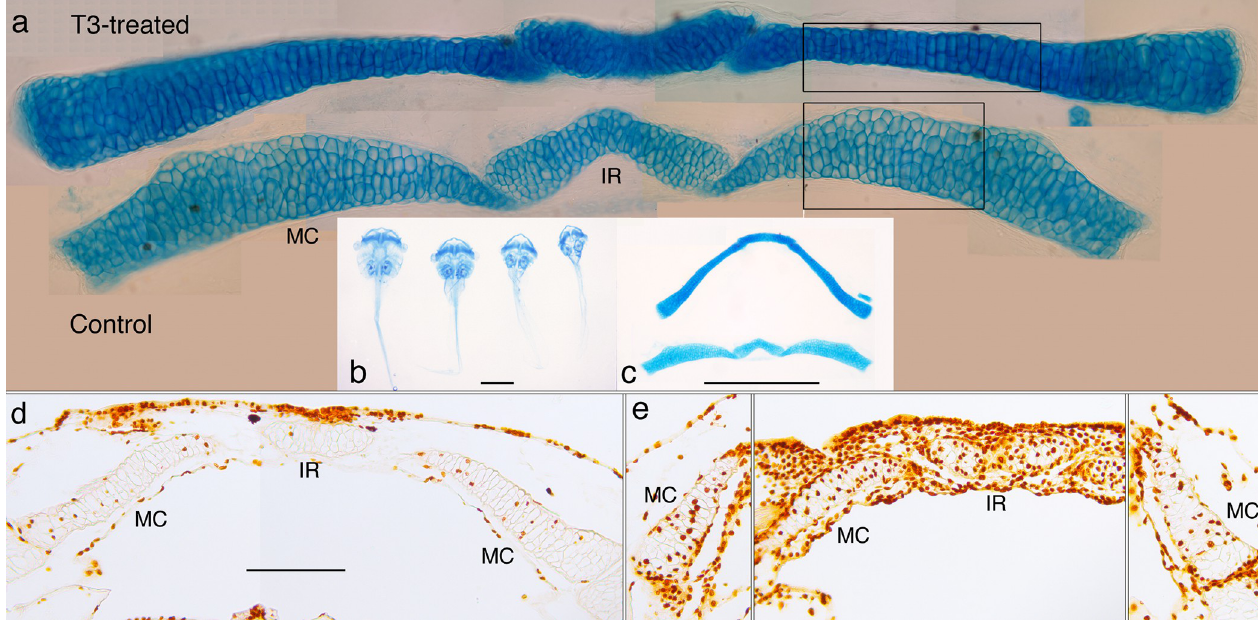
Fig 14. Effect of T3 on cartilage shape and cell behaviors in a NF 46 lower jaw. (a) the Meckel’s cartilage (MC) and infrarostral cartilage (IR) of a day 3, T3-treated specimen (upper) and a day 0, control specimen (lower) that were dissected from alcian blue-stained whole mounts of NF 46 specimens immersed in 50 nM T3. (b) ventral views of intact whole mounts treated for 1–4 days. (c) the cartilages after dissection. (d and e) frontal sections of BrdU-labeled lower jaws of day 3 control and day 3 T3-treated specimens respectively. Scale bars for b, c and d-e are 2, 1, and 0.5 mm